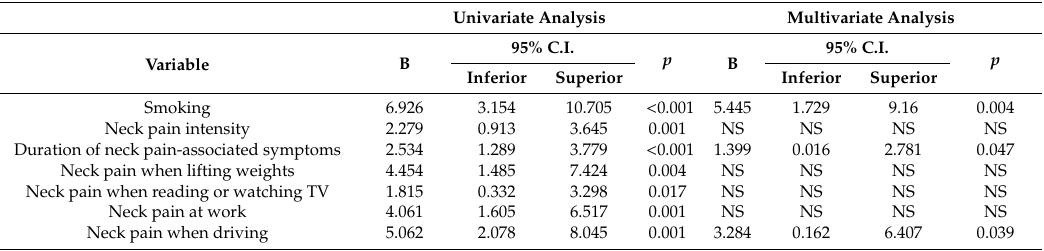
Table 4. Univariate and multivariate lineal regression to analyze the factors related to frequency of headache.